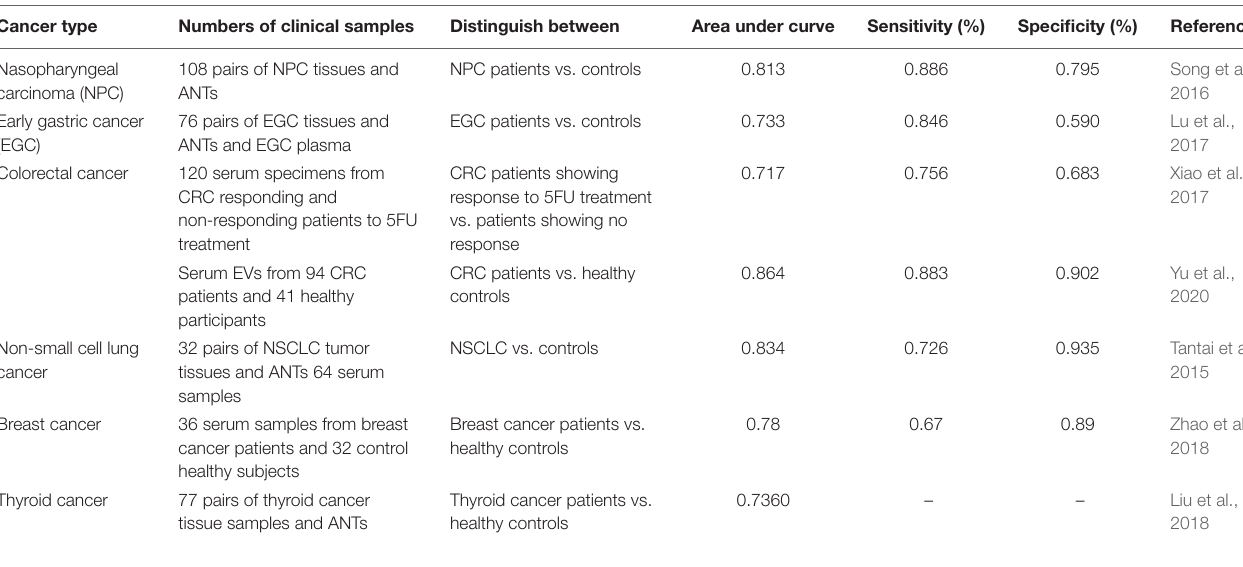
FIGURE 7 | The interactions between XIST and miRNAs in lung cancer cells. XIST has an oncogenic role in lung cancer through different mechanisms including epigenetically silencing of KLF2 expression (Fang et al., 2016). Moreover, it can enhance viability and invasiveness of lung cancer cells through regulation of miR-137/PXN axis (Jiang et al., 2018). XIST can also enhance TGF- β -associated epithelial-mesenchymal transition through regulation of miR-367/141-ZEB2 (Li et al., 2018). TABLE 2 | Diagnostic value of XIST in